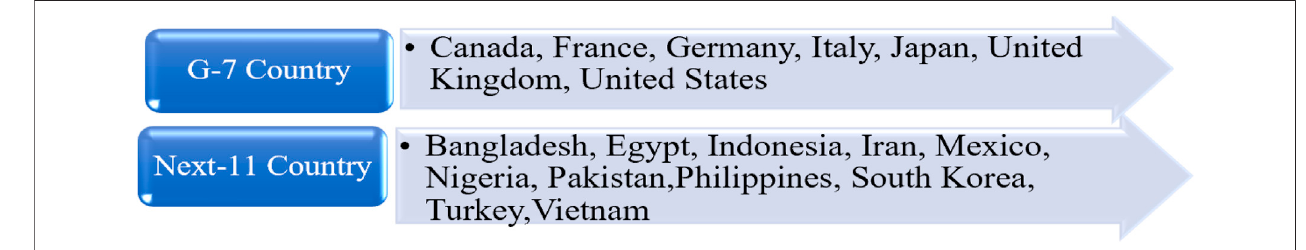
FIGURE 1 | (Group Seven) G7 and (Next-11) N-11 countries.